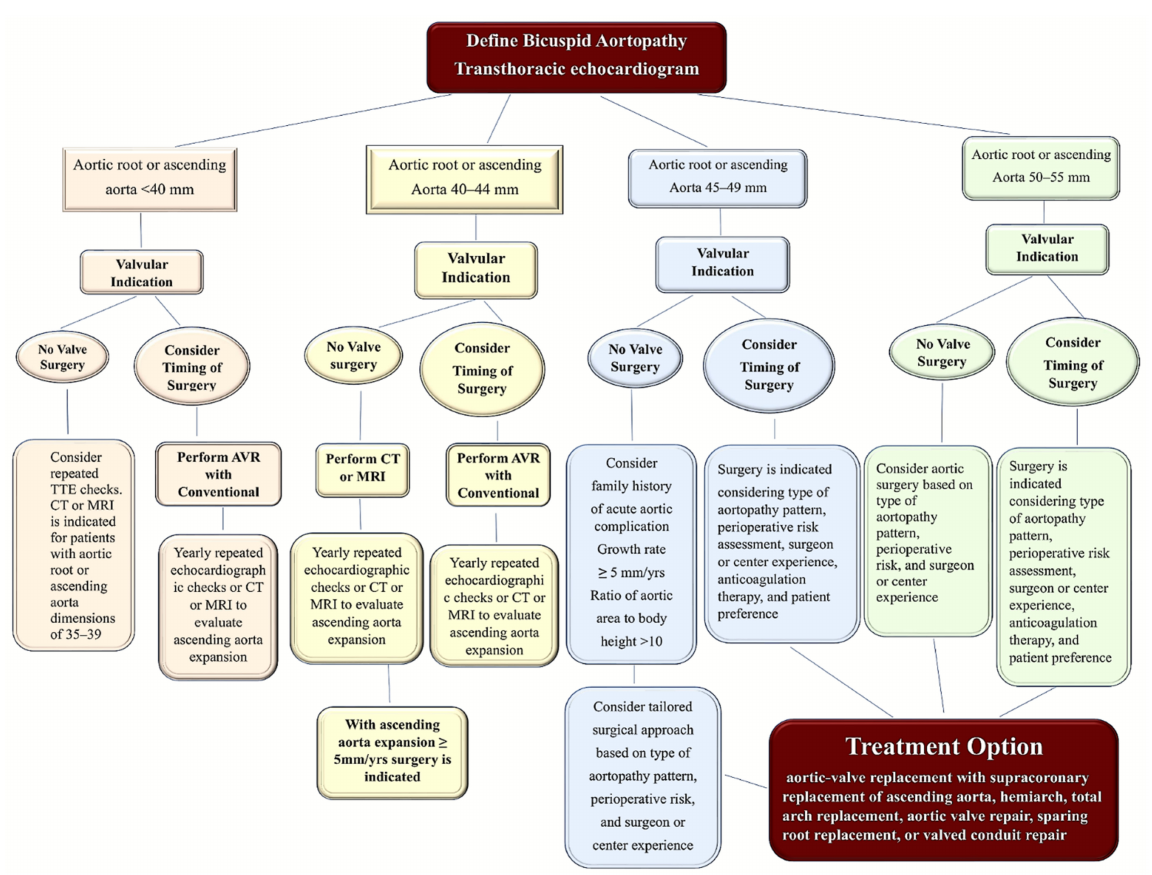
Figure 12. Decision-making algorithm for the management of the bicuspid aortopathy. Abbreviations; AVR, aortic valve replacement; CT, computed tomography; MRI, magnetic resonance imaging; TTE, transthoracic